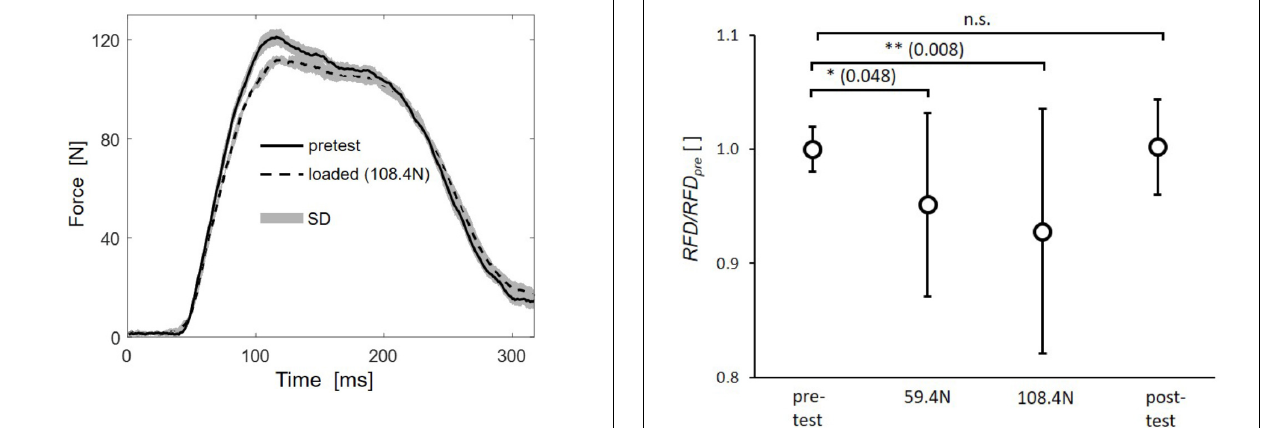
revealed a significant reduction of RFD by 5.0 ± 8.1%